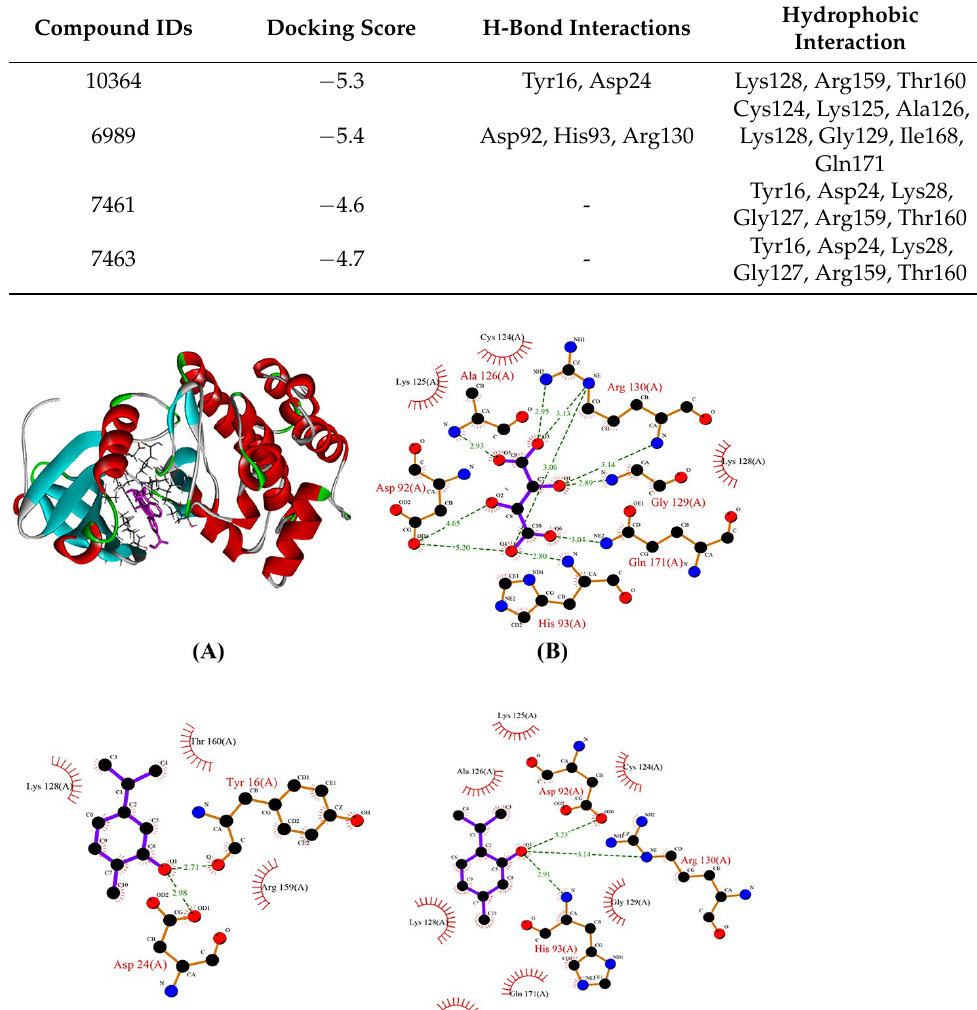
Table 4. Interaction of OEO compounds with PTEN.